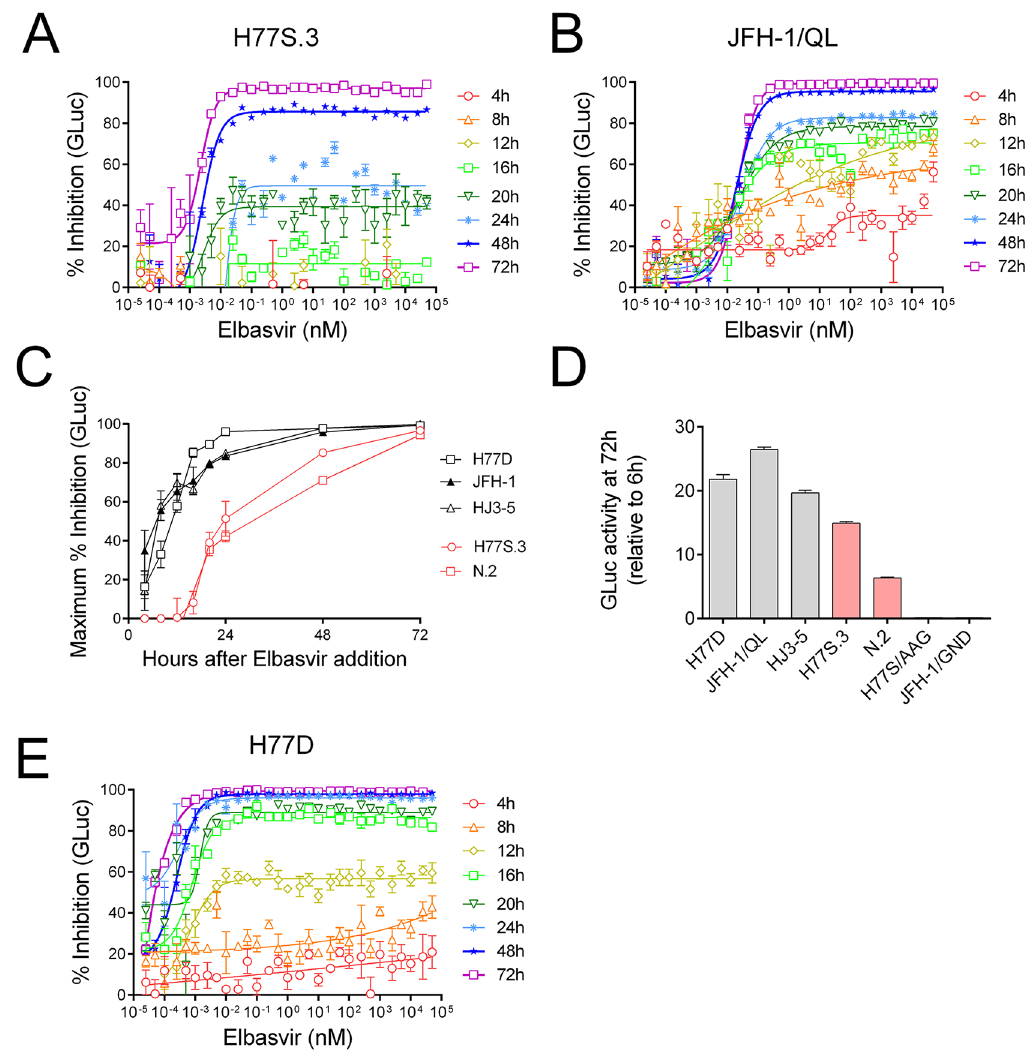
Fig 1. Kinetics of HCV inhibition in infected cell culture following addition of an NS5A inhibitor, monitored using different GLuc reporter viruses. (A) Inhibitionof the gt1a LPO S virus H77S.3/GLuc2A by elbasvir. (B) Inhibitionof the gt2a LPO R virus JFH-1/QL/GLuc2A by elbasvir.(C) Maximum % inhibition(E max ) of GLuc activity at different time points after additionof elbasvir to Huh7.5 cells infected with different cell culture infectiousHCV genomes.LPO S viruses H77S.3/GLuc2A (gt1a) and N.2/GLuc2A (gt1b) are plotted in red. LPO R viruses H77D/ GLuc2A (gt1a), JFH-1/QL/GLuc2A (gt2a) or HJ3-5/GLuc2A (gt1a/2a chimera). (D) Inhibition of the gt1a LPO R virus H77D-GLuc2A by elbasvir.(E) Fitness of different virus genomesused in (C) at 72 h post electroporation. Data shown represents GLuc activity relative to GLuc activity at 6 hours post electroporation to normalize for transfectionefficiency. The replicationincompetent reporter viruses H77S/AAG/GLuc2A and JFH-1/GND/GLuc2A contain point mutationsin the NS5B polymerase and are includedas mock-transfection controls.